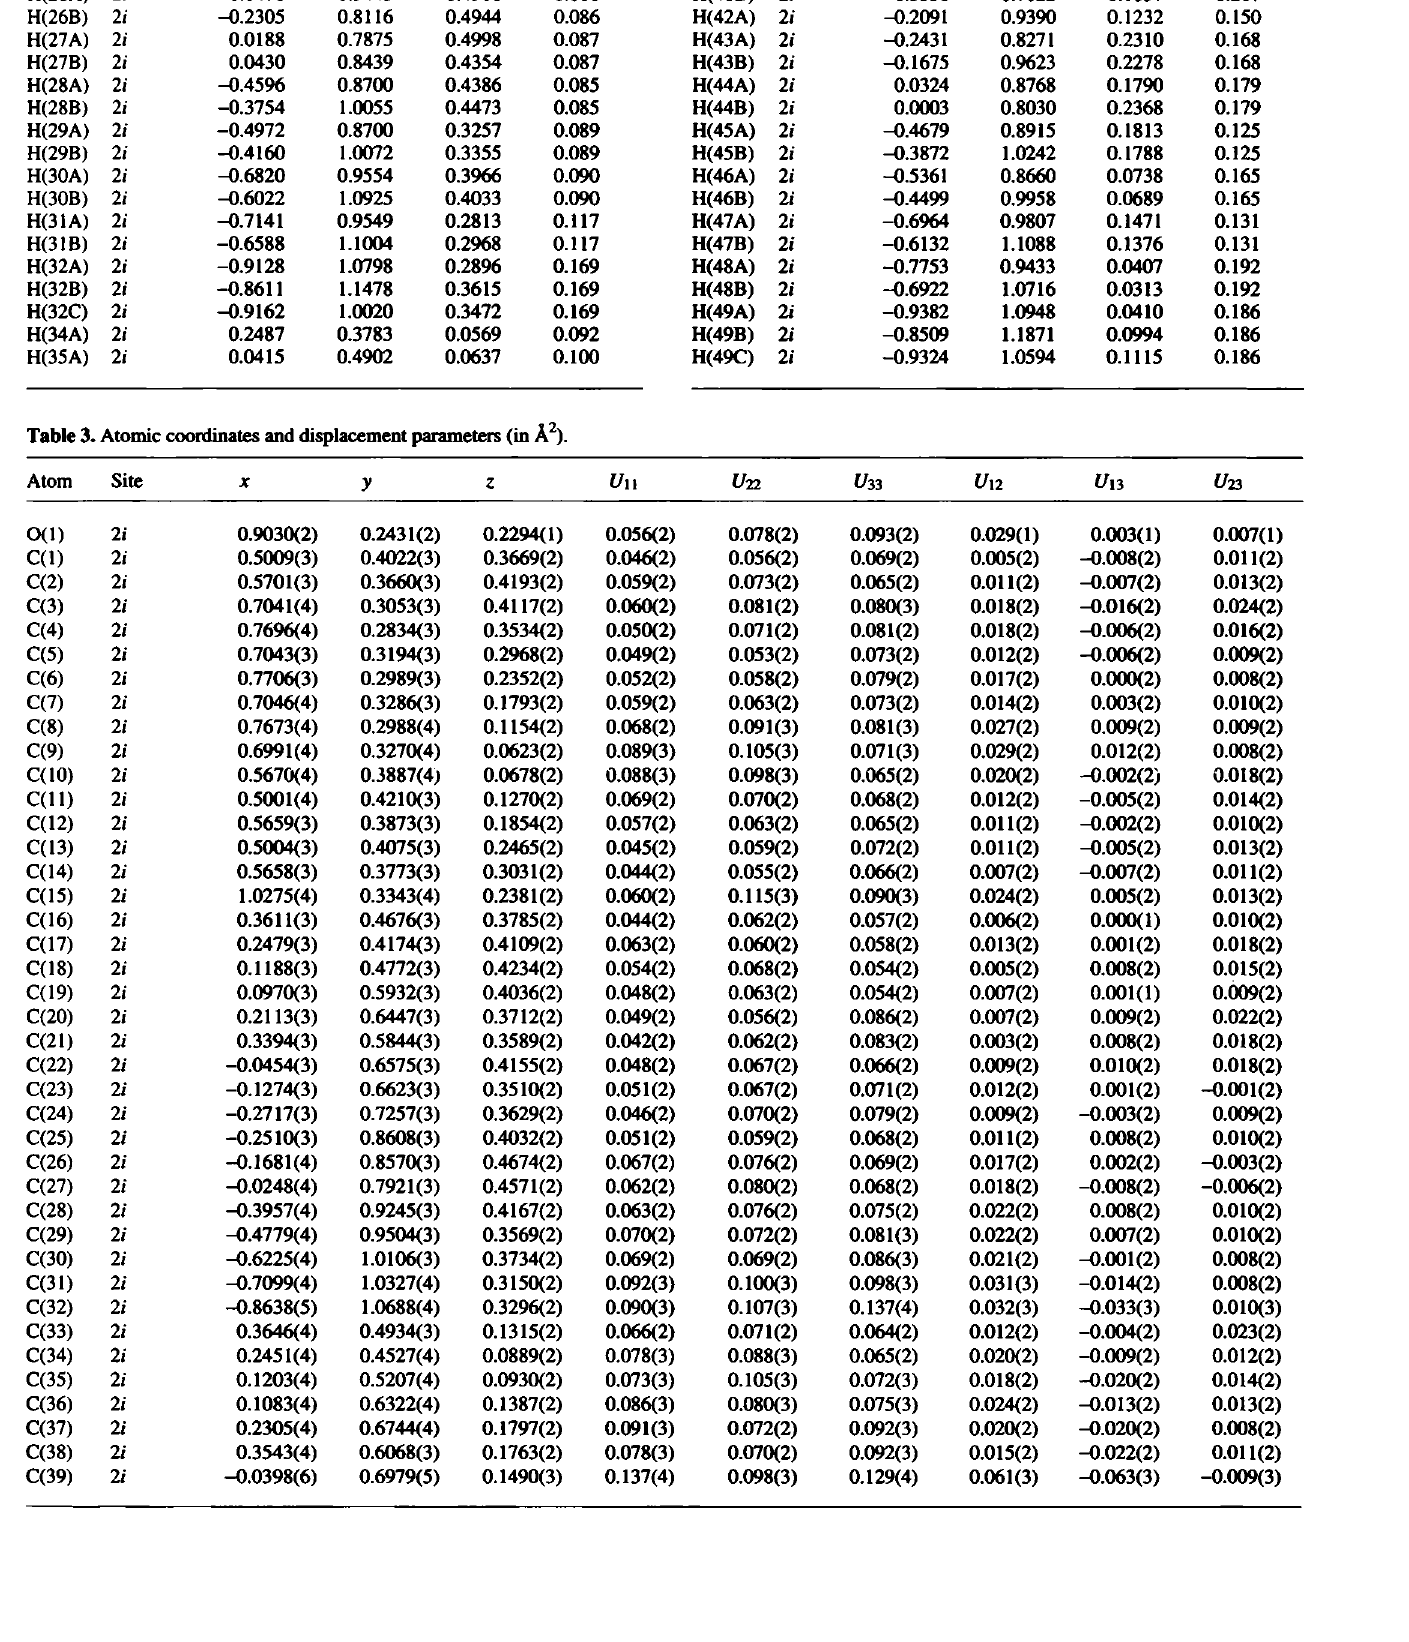
Table 3. Atomic coordinates and displacement parameters (in Â 2